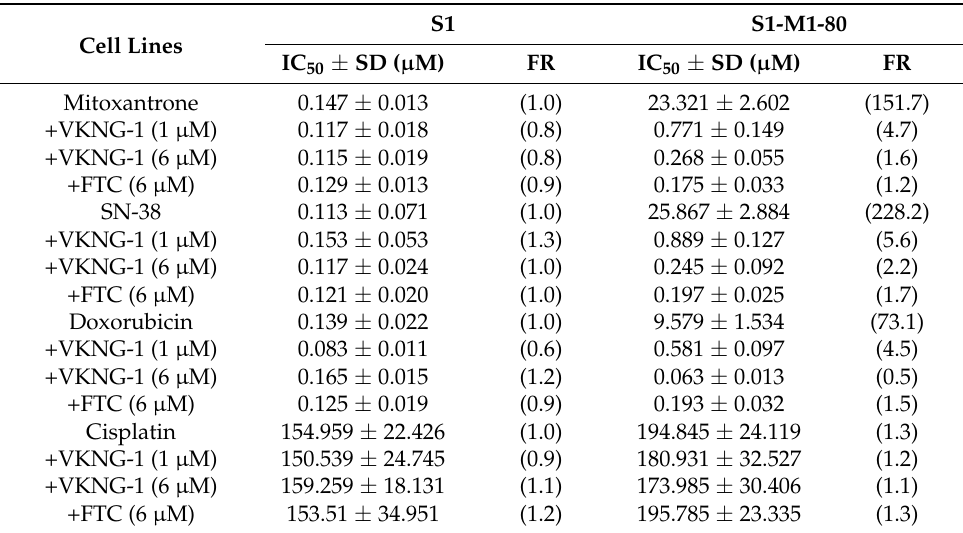
Table 1. The effect of VKNG-1 on the reversal of ABCG2-mediated